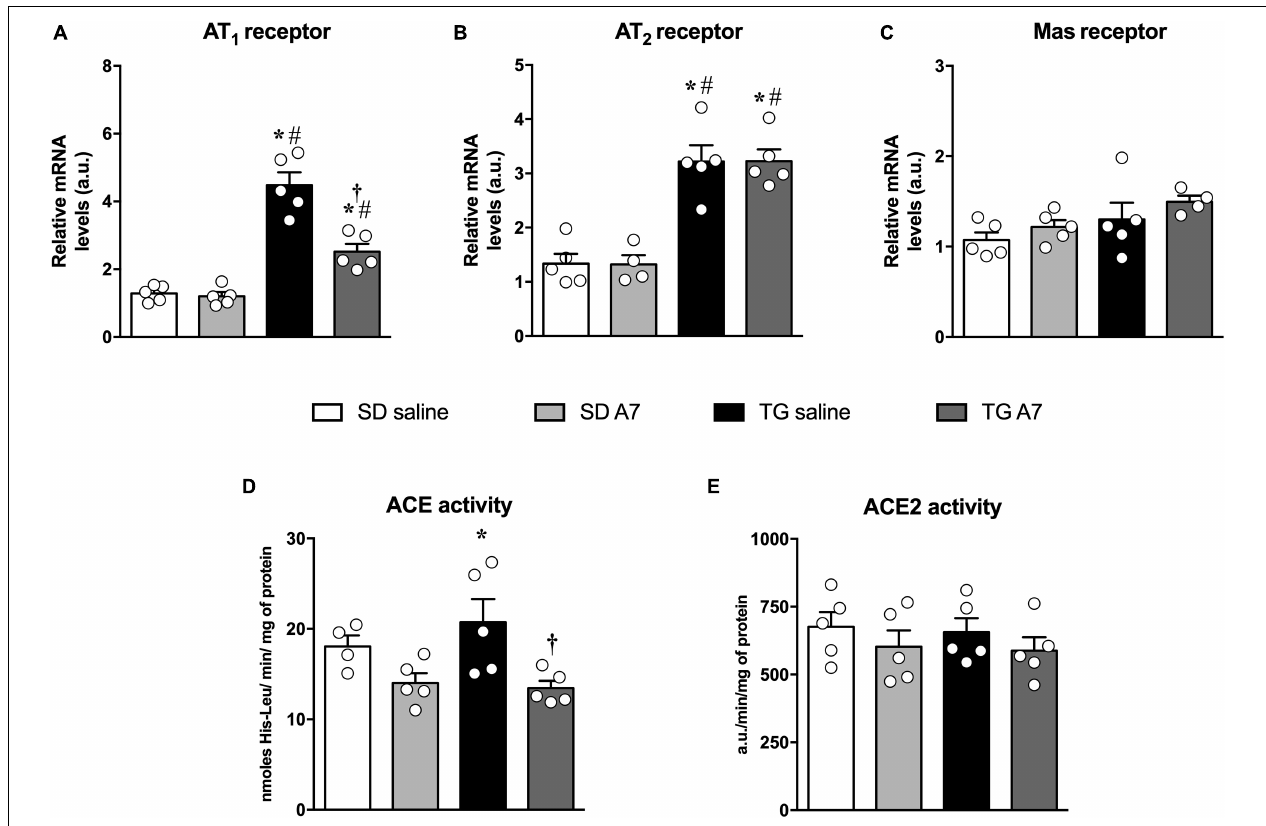
FIGURE 3 | Expression or activity of renin-angiotensin components in the hypothalamus in SD and hypertensive rats treated with Ang-(1-7) ICV. AT 1 receptor (A) , AT 2 receptor (B) , Mas receptor (C) , ACE activity (D) , and ACE2 activity (E) . Results are expressed as mean ± SEM. n = 4 or 5. * p < 0.05 vs. SD saline; # p < 0.05 vs. SD A7; † p < 0.05 vs. TG saline (One-way ANOVA followed by Newman-Keuls post hoc